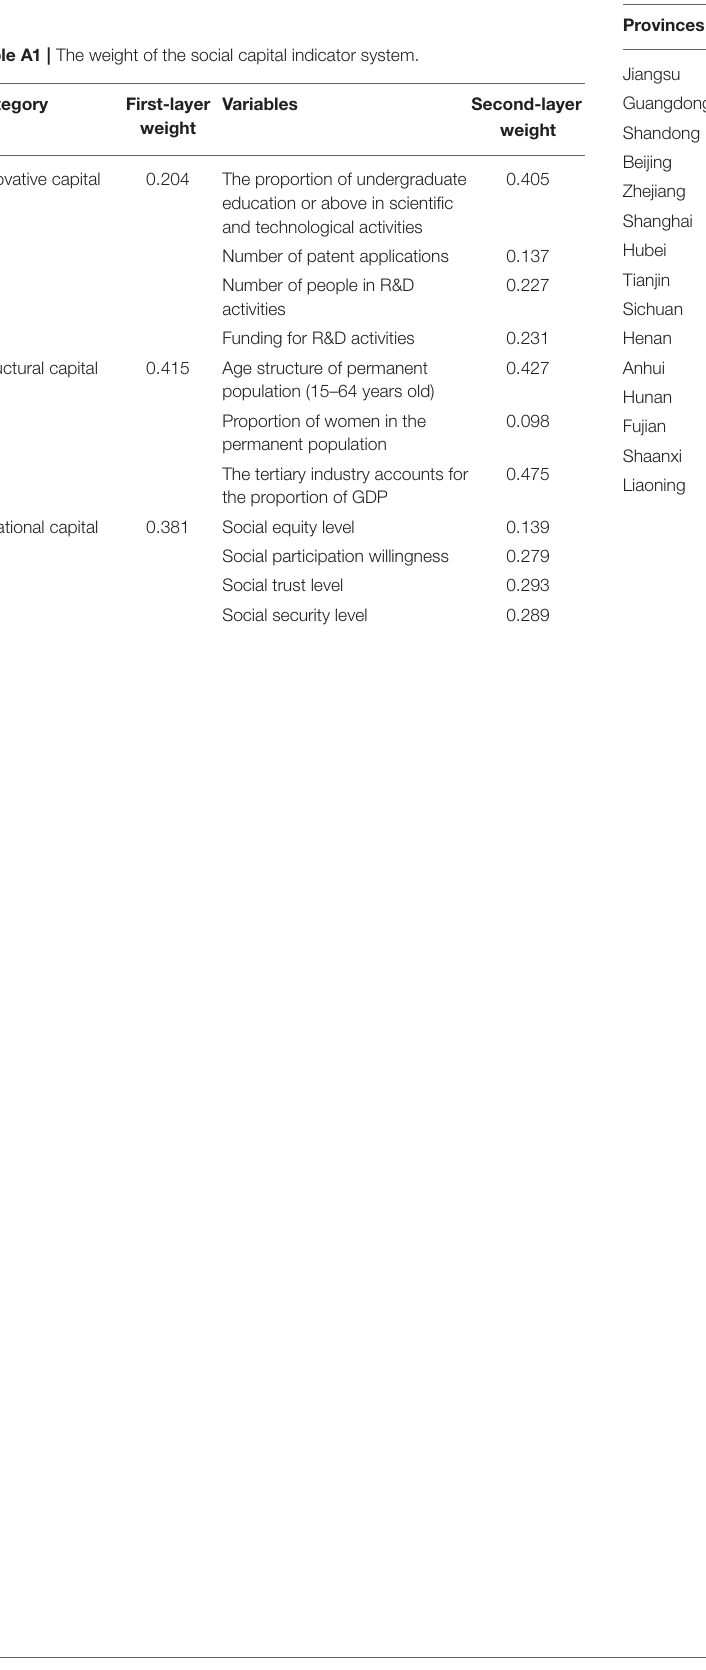
Table A2 | The SCL results of the provinces in China in